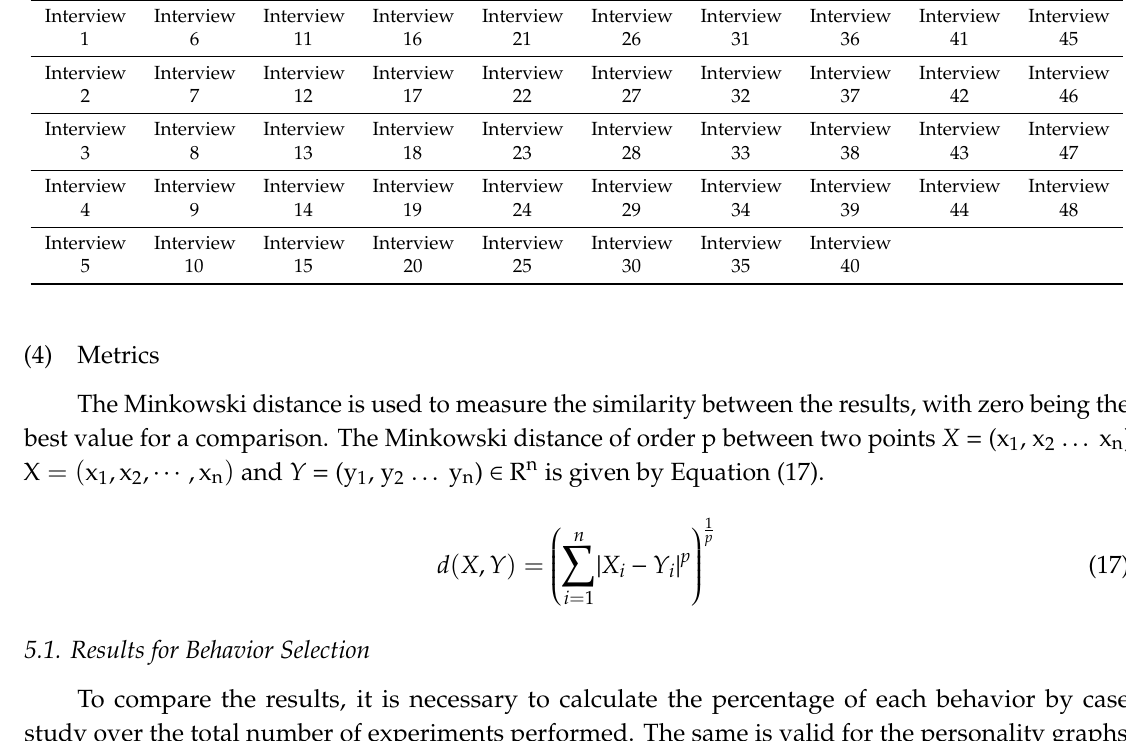
Table 11. Distribution of the interviews conducted, taking into account all the robot’s personalities.